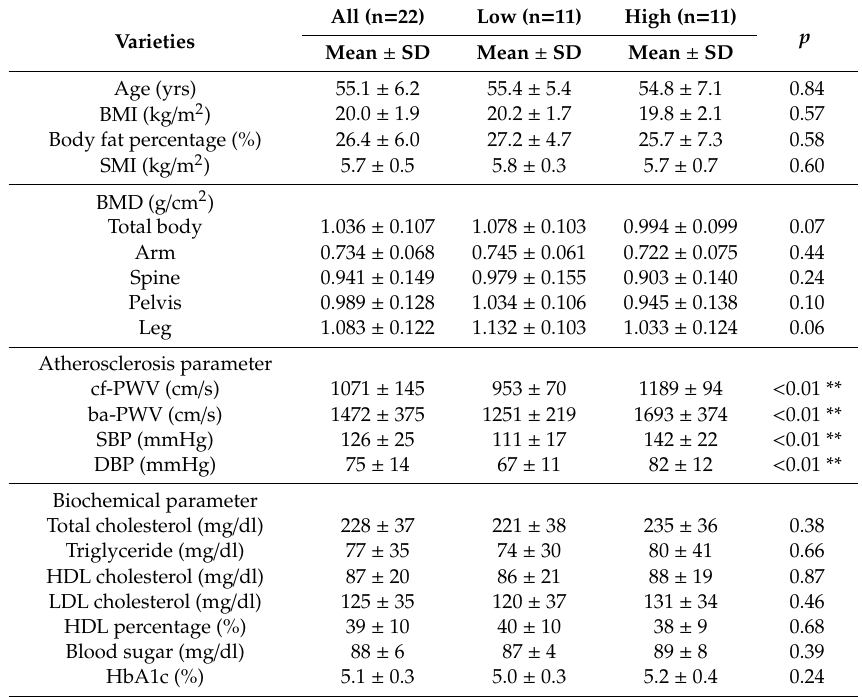
Table 1. Subject characteristics at baseline for the whole study group and for Low- and High-PWV groups separately.